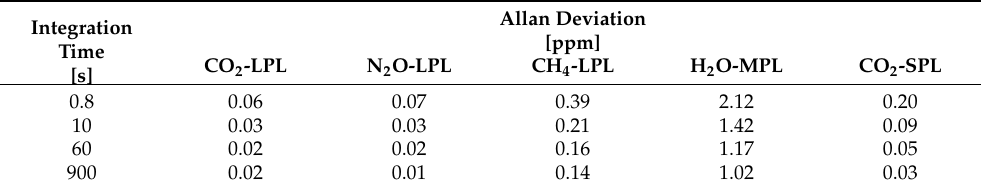
Figure 5. Allan deviation log plots as derived experimentally for CO 2 (measured in both LPL and SPL channels), H 2 O (MPL channel), and for CH 4 and N 2 O (LPL channel) by measuring a dry ‘zero gas’ (Nitrogen) over a 60 h period in stable lab conditions (temperature kept constant at 20 ˚ C ). Table 2. Summary of the Allan deviation measurements of all measured gases, listing application-relevant integration times and the associated ppm levels, separated to the utilized propagation channels.